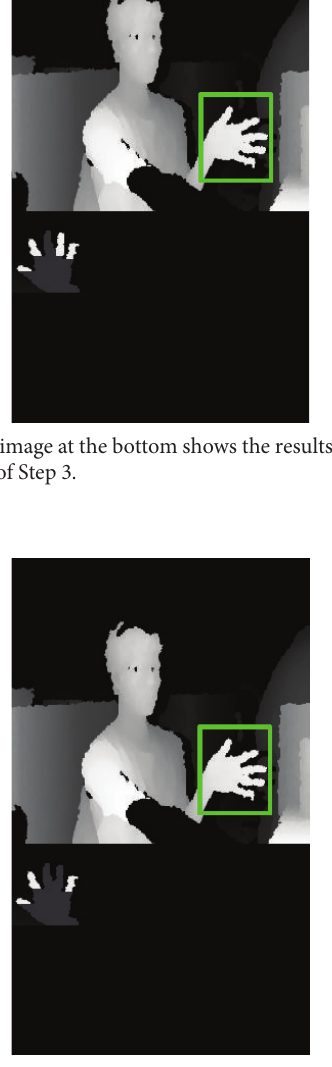
Figure 11: The image at the bottom shows the results after finishing the second round of Step 3.